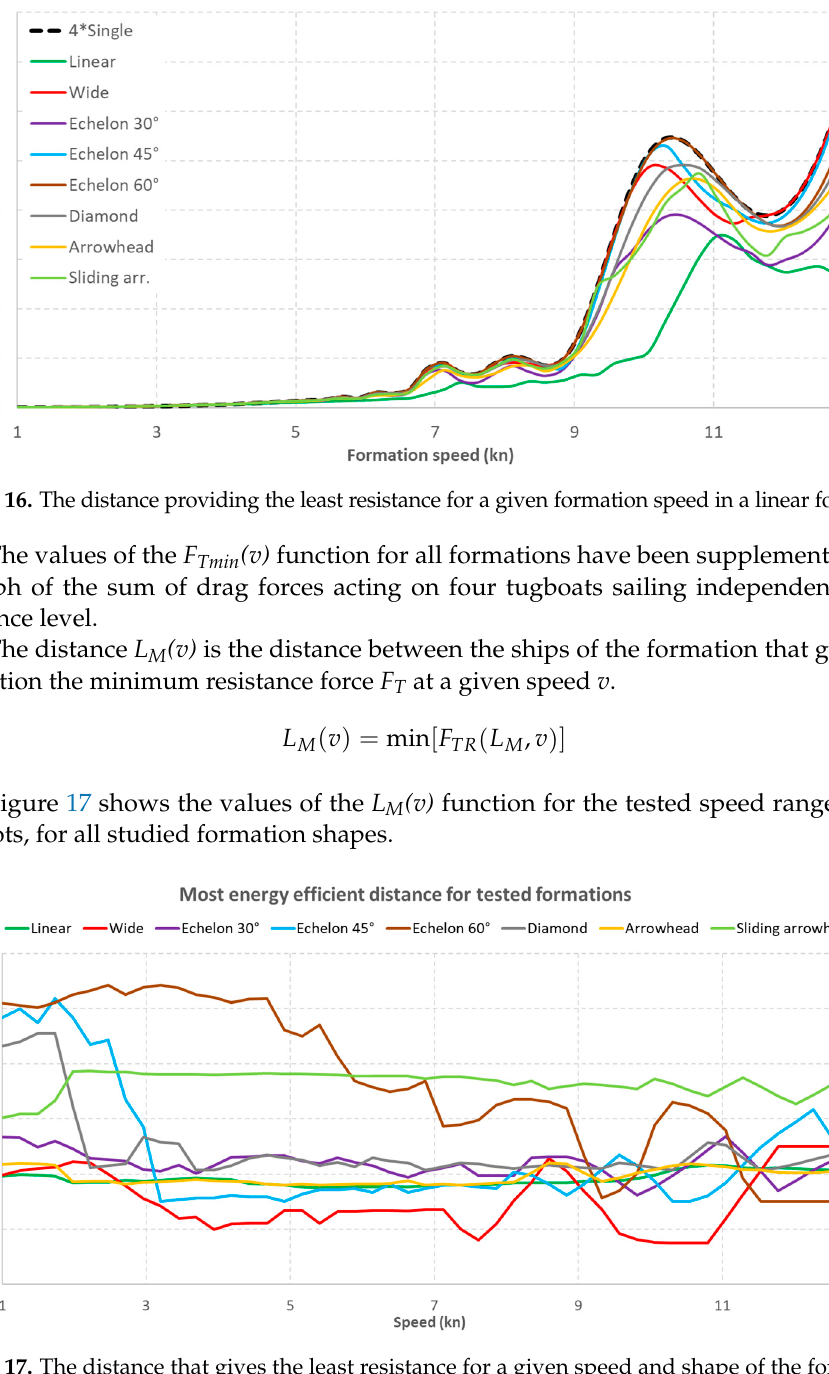
Figure 18. Distance providing the least resistance for a given formation speed in a linear formation. 4.3. Tug Formation Resistance Simulation Tests In order to verify the energy consumption of tugboats sailing independently and in formations of various shapes, a proprietary simulation environment was used – a net- work ship traffic simulator. This simulator allows to define a route consisting of way- points, which is then followed by the tested ship. This tool also allows to simulate weather conditions, such as wind with variable strength and direction, as well as sea currents, also with variable strength and direction. Figure 19 shows the route followed by the simulated tugboat. It consists of 10 way- points, and after reaching waypoint 5, the tug makes a turn and returns along the same path. Therefore, some of the waypoints have the same coordinates. The preset route is shown with a dashed line, and the numbers shown correspond to the waypoint numbers. Figure 19 also shows position markers showing the trajectory of the simulated tugboat. The path shown in red represents tug movement from the starting position to waypoint 5, and in green from waypoint 5 to waypoint 10 (final position).